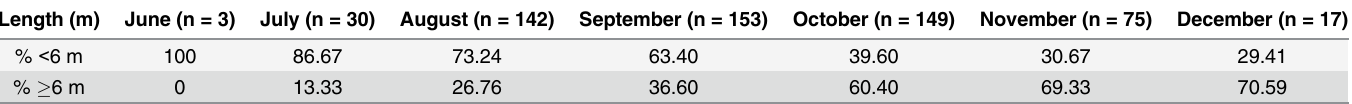
Table 1. Percent of small ( < 6 m) and large (% (cid:1) 6 m) dead calves by month (n =